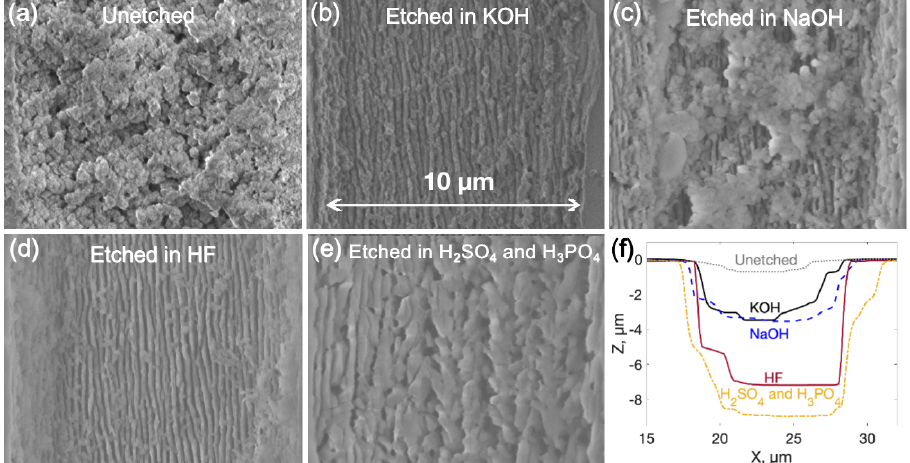
Figure 4. SEM pictures of laser-irradiated surface morphologies and measured profiles of the processed material. ( a ) Unetched surface modification, ( b ) surface modification etched in 35% KOH solution for 1 h, ( c ) surface modification etched in 25% NaOH solution for 1 h, ( d ) surface modification etched in 48% HF for 1 h, and ( e ) surface modification etched in H 2 SO 4 and H 3 PO 4 for 20 min. ( f ) Optical profilometer measured processed profiles of all presented